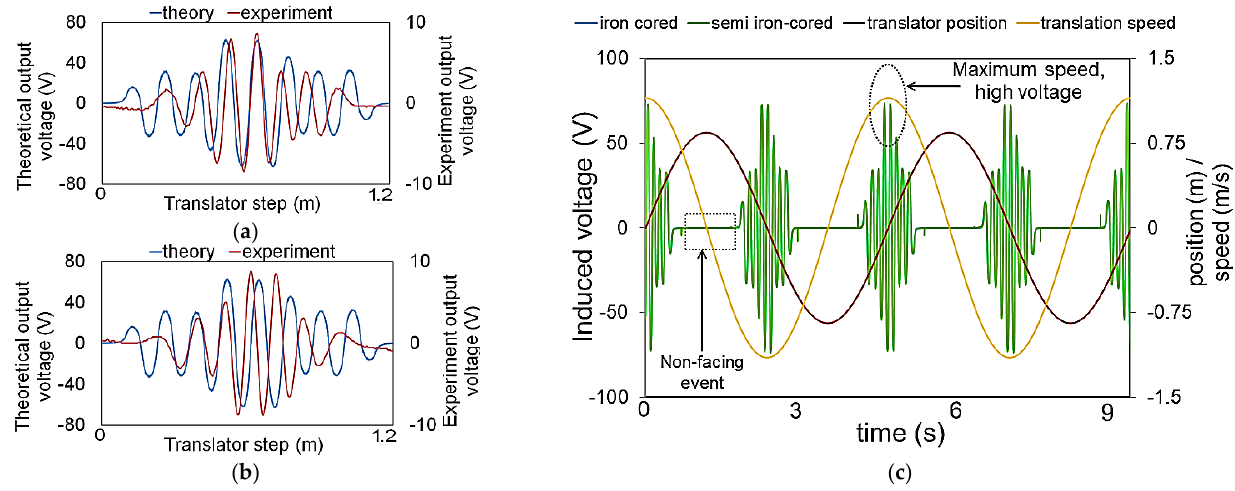
Figure 17. The graphs of the induced voltage of ( a ) iron-cored LPMG and ( b ) semi iron-cored LPMG from calculation and experiment; ( c ) induced voltage of LPMG designs under the regular wave.